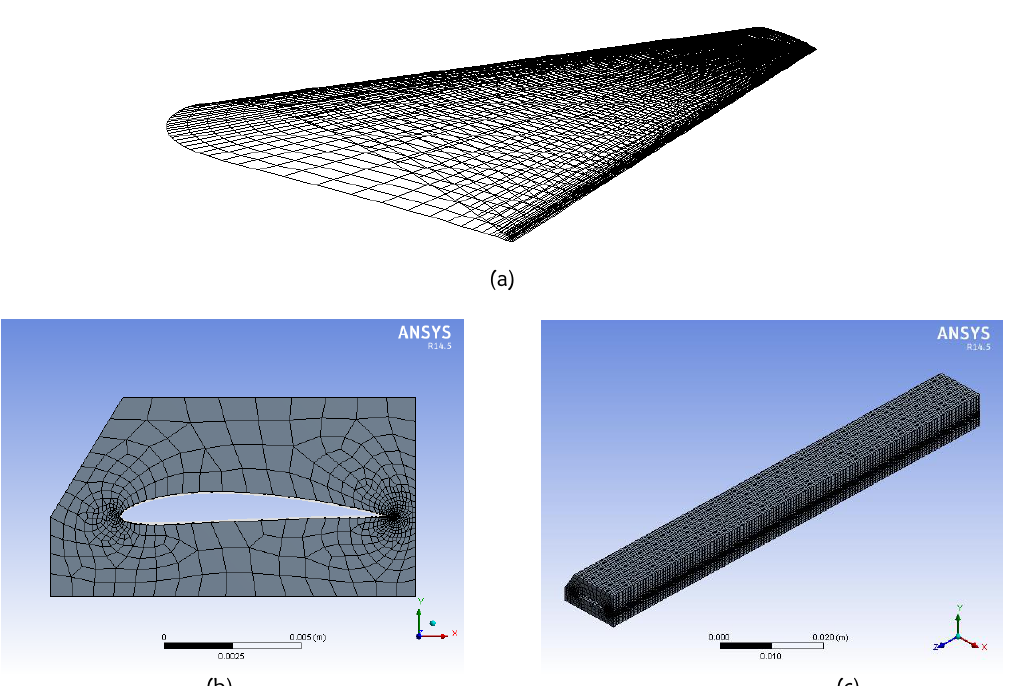
Figure 2: (a) Wind turbine blade surface meshing; Meshing of fluid domain with 60° impingement angle (b) cross- sectional view, (c) three dimensional view.